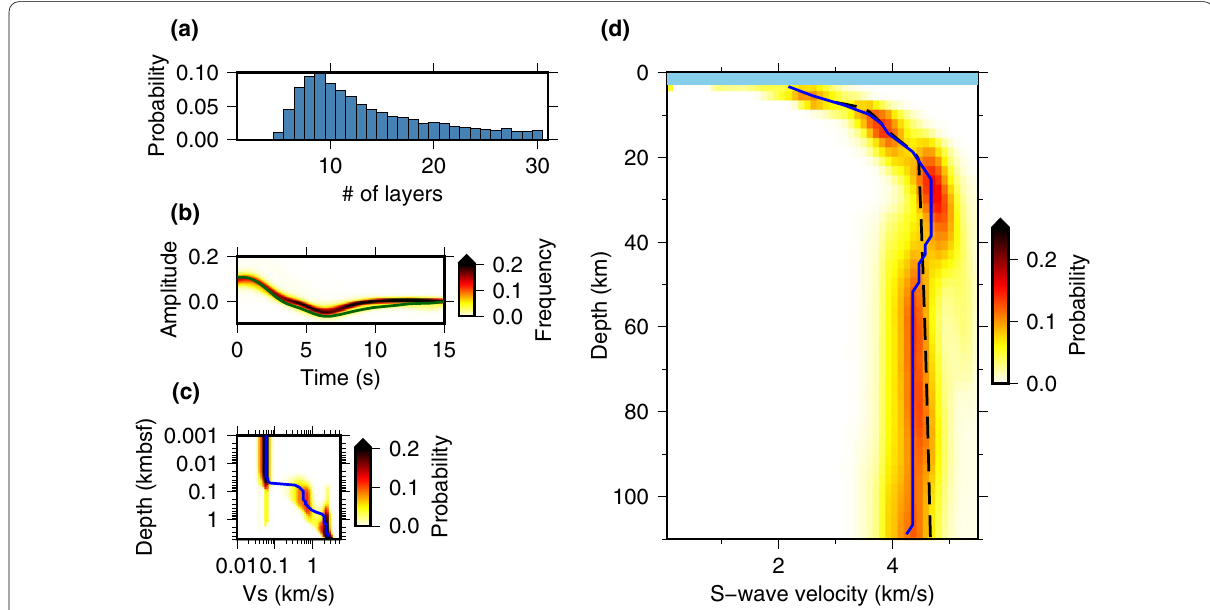
Fig. 5 Inversion results for station YMB3 located at the Yamato Basin. a Posterior probability of the number of layers. b Frequency distribution of predicted S-receiver functions. The background color shows the distribution, and the green line denotes the observed S-receiver function. c , d Posterior marginal probability of the S-wave velocity at each depth bin: c enlarged view for the seafloor sediment; d overall view. The background color shows the probability. Blue solid and black dashed lines denote the median and reference models,